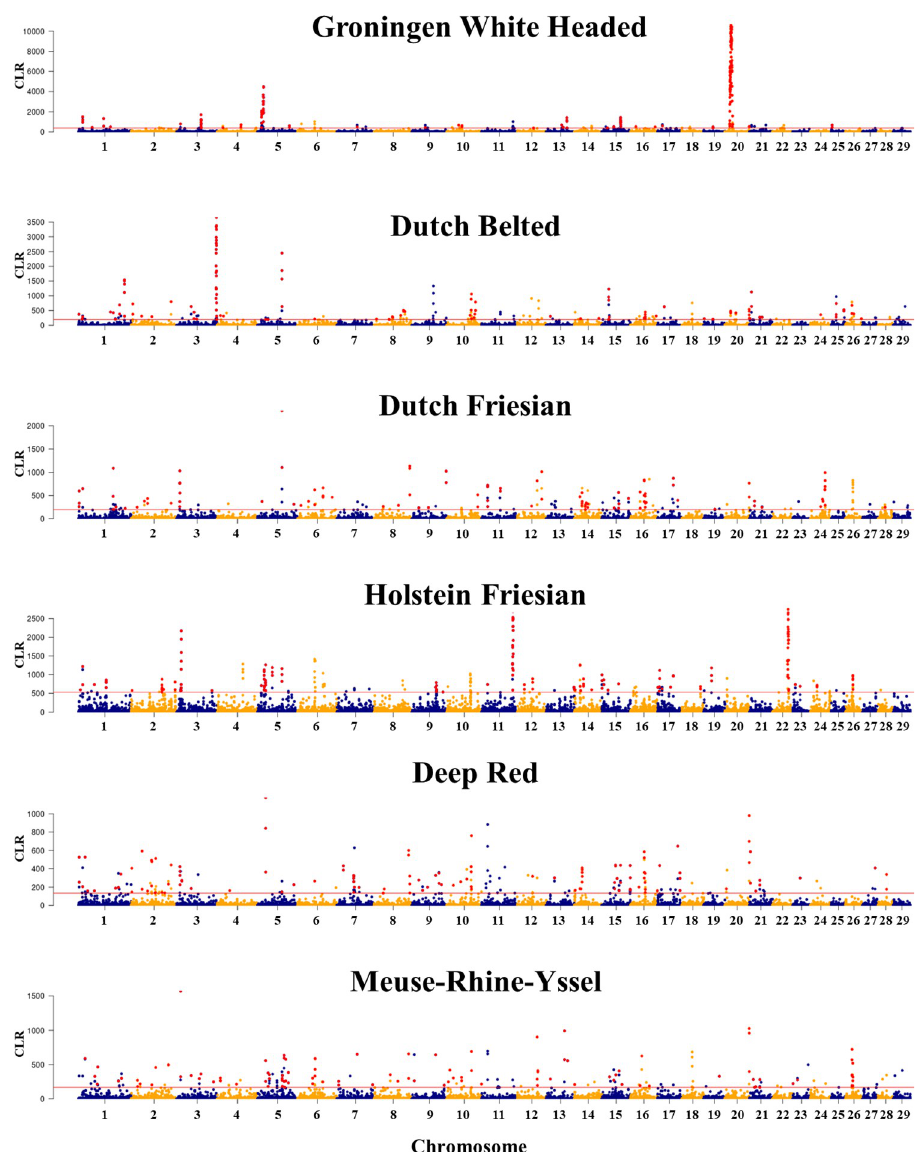
Fig 4. Genome-wide selective sweep scans using SweeD in each breed. Manhattan plots representing the composite likelihood ratio values (y-axis) from SweeD for each marker across the genome (x-axis). The threshold of the significant association (top 1% of the highest composite likelihood ratio values) for declaring candidate selective sweeps is indicated by the red line. Red points indicate candidate genomic regions detected by both the SweeD and OmegaPlus